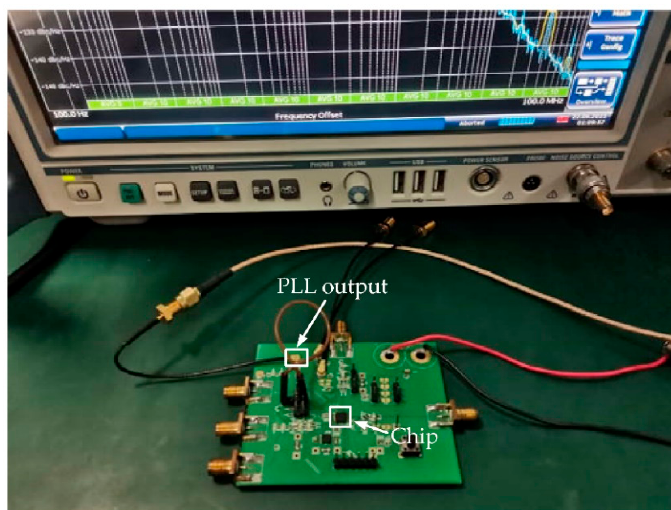
Figure 13. Measurement setup.